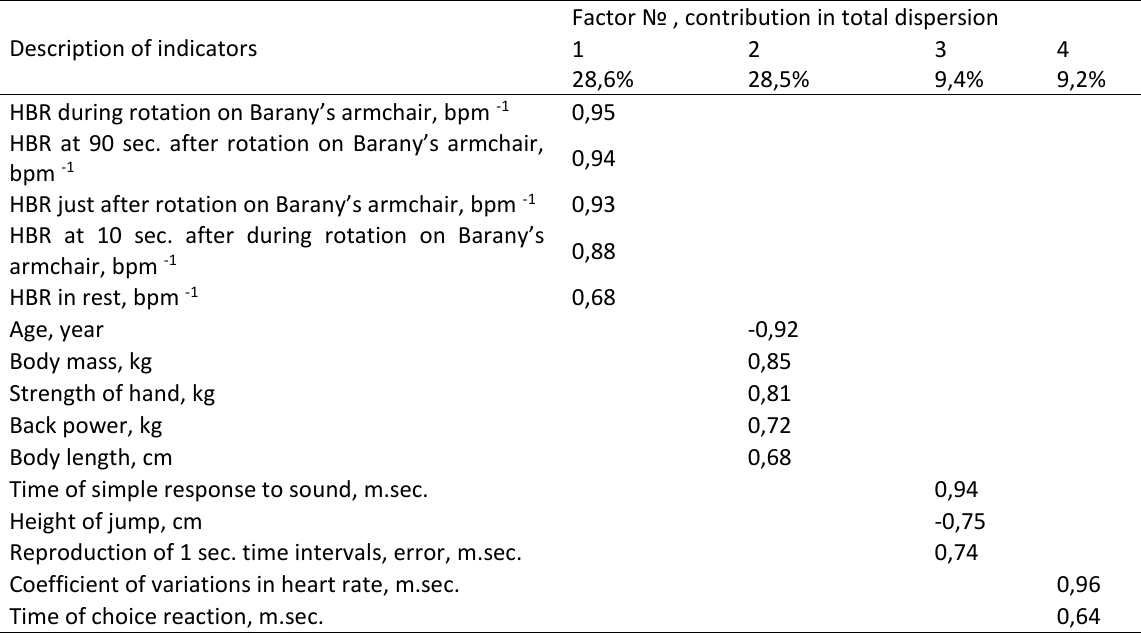
Table 1. Rotated matrix of testing indicators’ components of elite judo wrestlers (n=22) Description of indicators